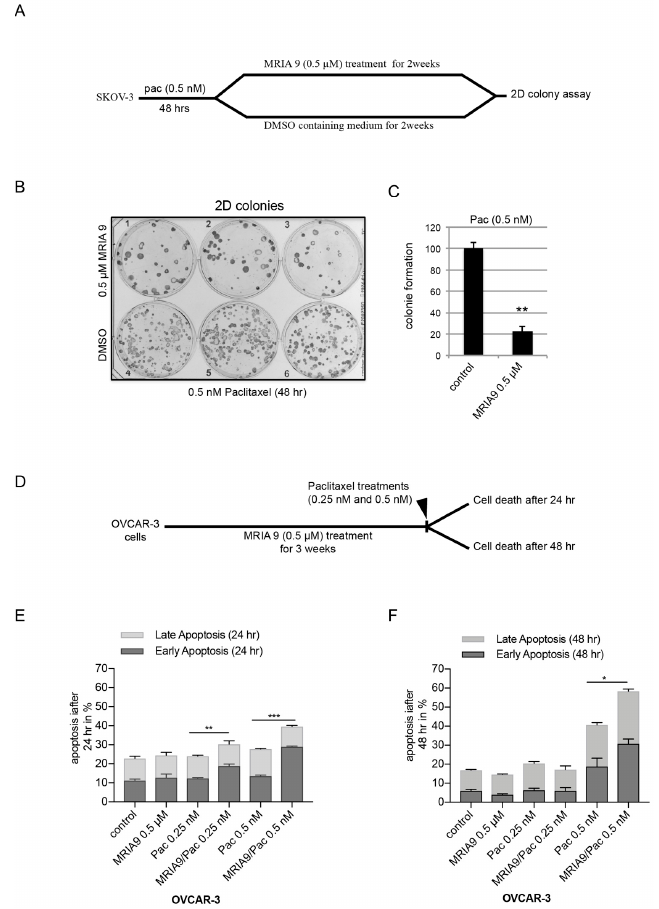
Figure 5. MRIA9-induced long-term inhibition of SIK2 decreases survival and sensitizes ovarian cancer cells to paclitaxel treatment. ( A ) Scheme of the experimental procedure. SKOV-3 cells were first incubated with 0.5 nM Pac for 48 h. On day two, cells were washed and incubated with and without 0.5 µM MRIA9 containing medium for two weeks. ( B ) SKOV-3 cells grown in colonies were subjected to Coomassie blue staining. ( C ) The number of colonies was determined and repre- sented as a bar graph. ( D ) Scheme of the experimental procedure. OVCAR-3 cells were first treated for three weeks with 0.5 µM MRIA9. Subsequently, 0.25 nM and 0.5 nM Pac were added to the cultures. Cell death was then assessed after 24 h ( E ) and 48 h ( F ) using Annexin V/AAD. The results are presented as mean ± SD. The total apoptosis (early and late) was used for statistical analysis. *** p < 0.001, ** p < 0.01, * p < 0.05.